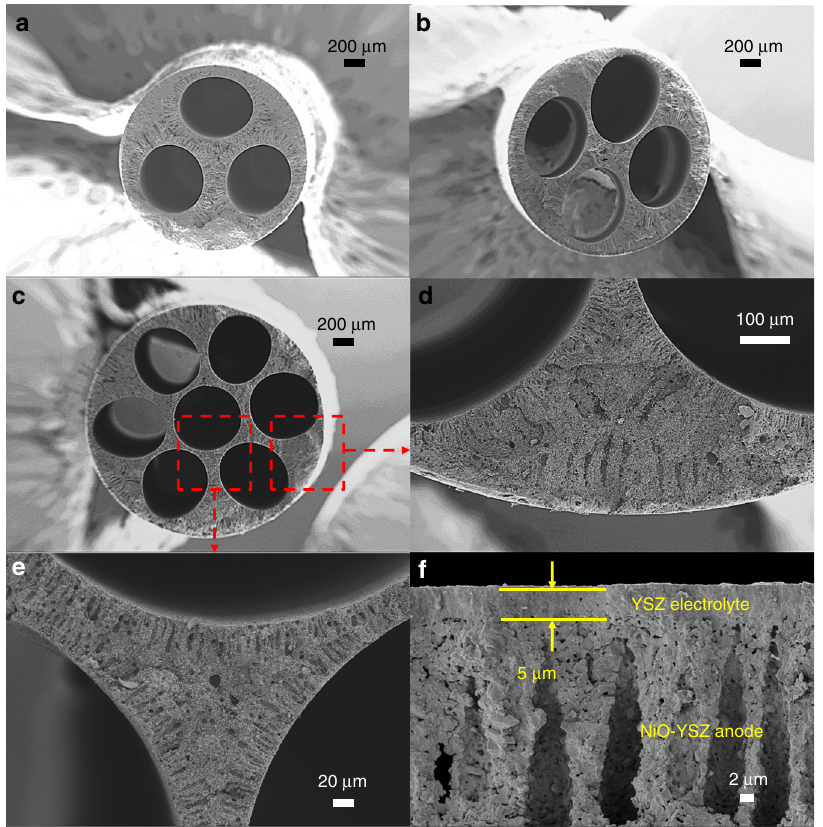
Fig. 1 Various micro-monolithic anode supports after sintering at 1450°C. SEM images of central-axis-view of: a 3, b 4, and c 7 channels; Cross-sectional images of d sponge between the shell and two channels in the 7-channel anode, e sponge between the central channel and surrounding two channels in the 7-channel anode; f close-up image of anode/electrolyte